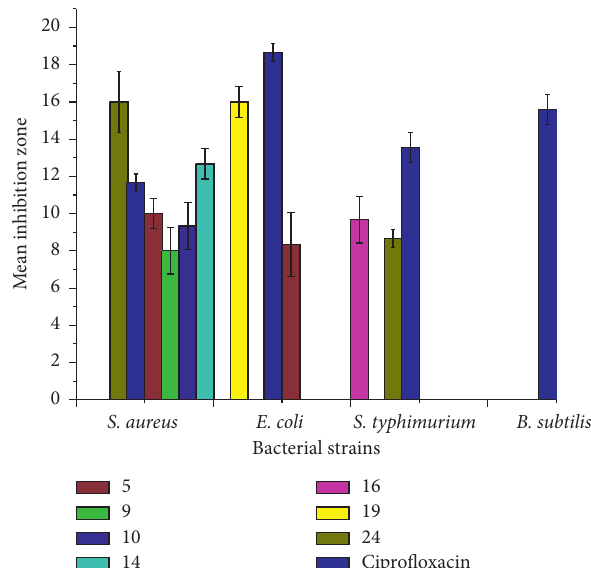
Figure 2: The binding interactions of ciprofloxacin against E.coli DNA gyrase A (PDB ID: 1ZI0).